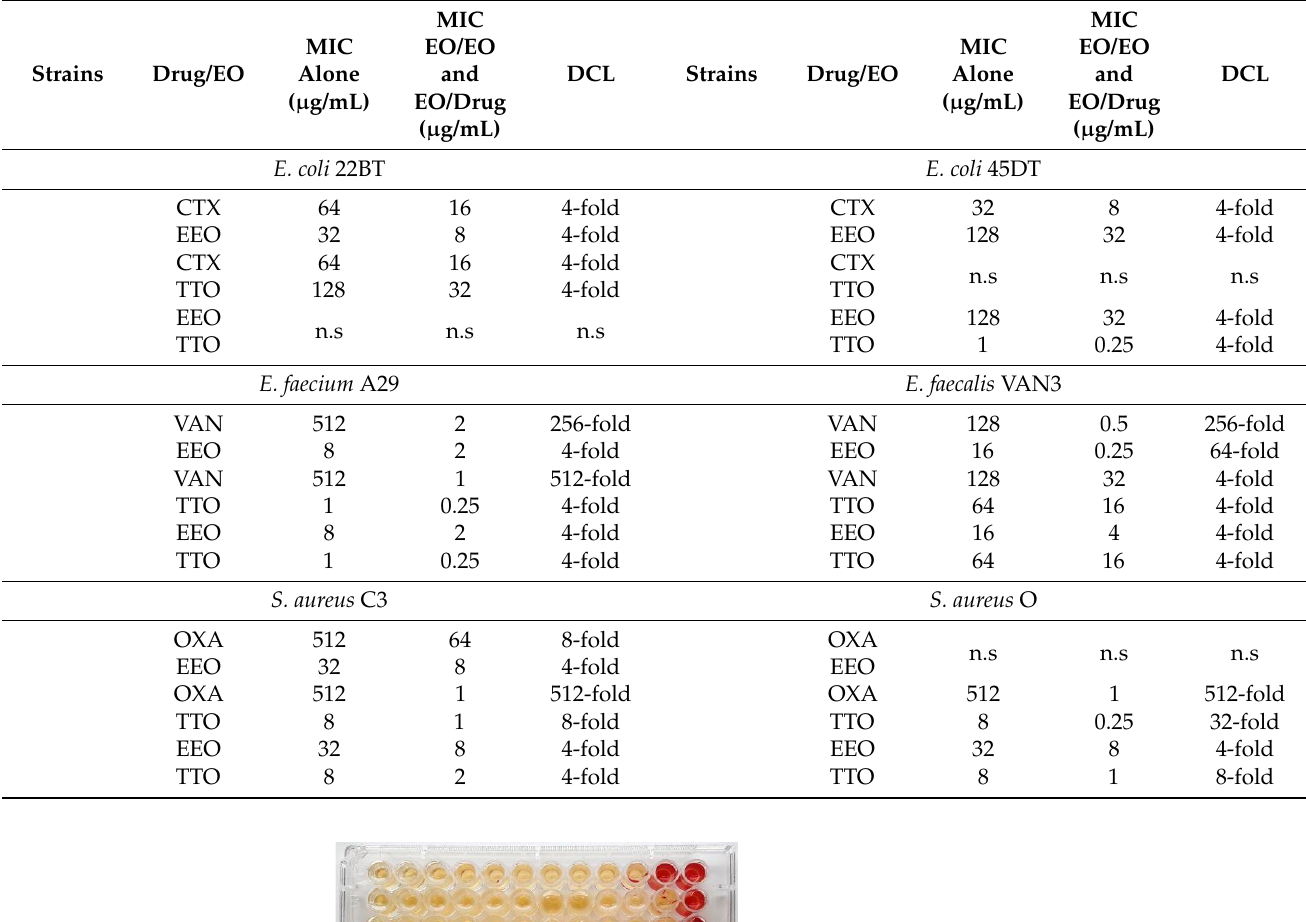
Table 2. MIC ( µ g/mL) of antimicrobials alone, and of EO/EO association, and EO/antibiotic combination against ARB pathogens in planktonic form. DLC: Drug Lowering Concentration. EEO: eucalyptus, TTO: tea-tree, CTX: cefotaxime, VAN: vancomycin, OXA: oxacillin and n.s.: no synergy.